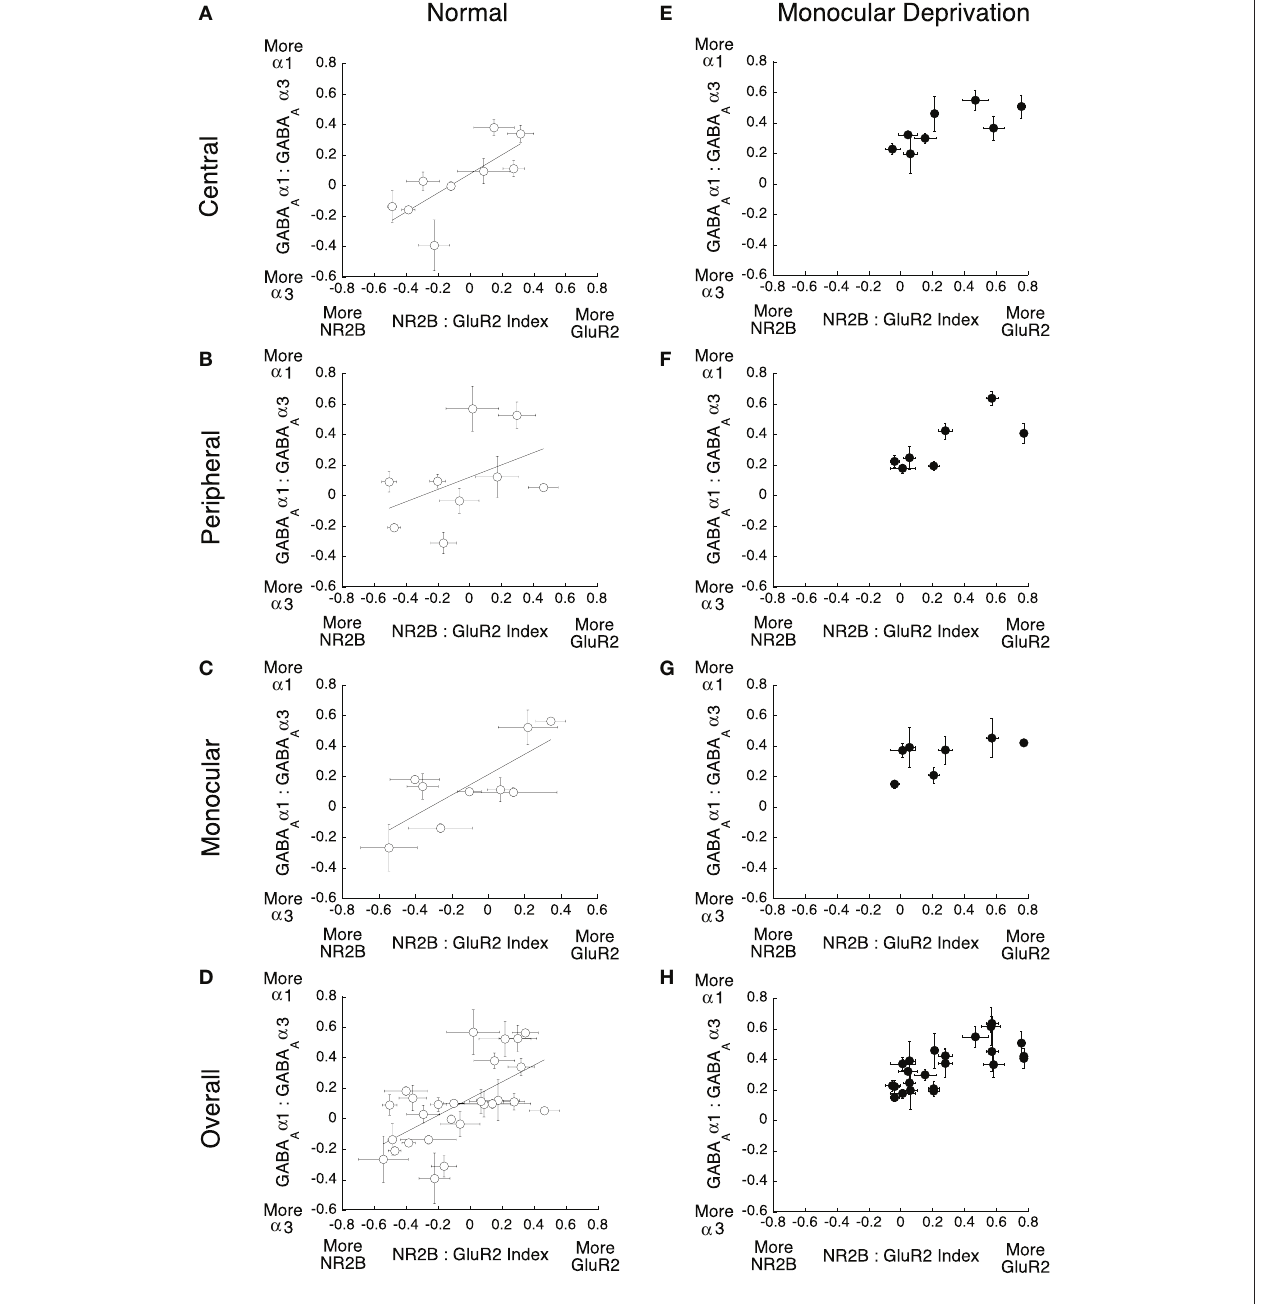
FiGure 8 | Monocular deprivation disrupts the balance between correlations were found for normal animals (A) central ( r = 0.75 p < 0.025), Nr2B:Glur2 and GABA α 1:GABA α 3. The relationship between these indices (B) peripheral ( r = 0.65 p < 0.05) (C) monocular ( r = 0.77 p < 0.01), and (D) overall A A was plotted for (A–D) normal and (e–H) monocularly deprived animals. Significant ( r = 0.62 p < 0.01), but no significant correlations were found for deprived ( Figure 9A ). The second principal component explained 19% and the third component describes 9% of the variance. Beyond the third component (components 4–7), gradually less of the variance was explained (6–2% respectively). Since the first three principal components accounted for 85% of the variance these were determined to be the significant components of the SVD (Everitt and Dunn, 1991).